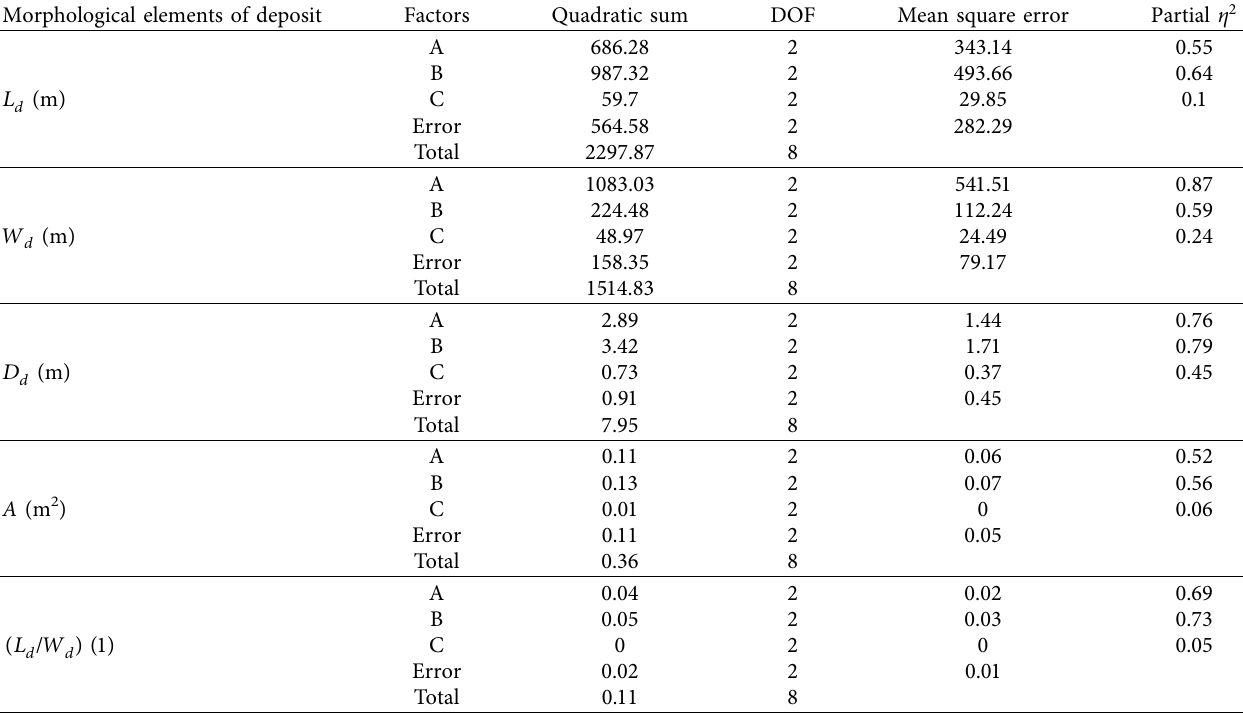
Table 5: Variance analysis